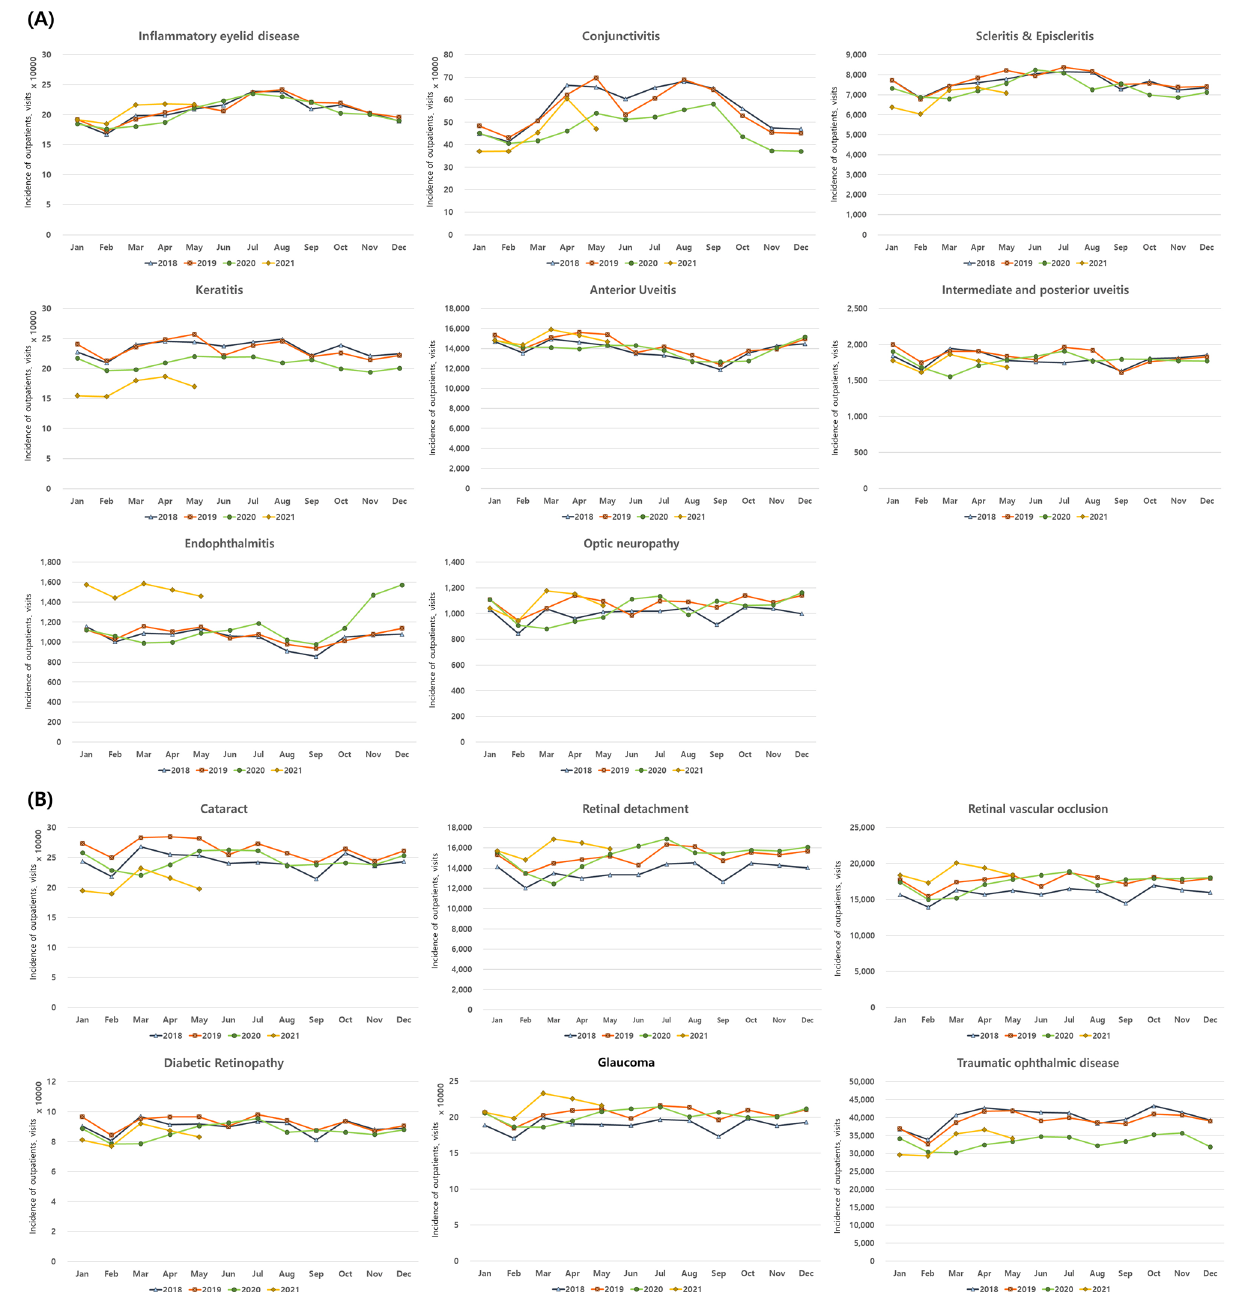
Figure 2. Monthly ophthalmic disease incidences (i.e., outpatient visits) during 2018, 2019, 2020, and 2021. The incidences of ( A ) infectious and inflammatory ophthalmic diseases (i.e., inflammatory eyelid disease, conjunctivitis, scleritis & episcleritis, keratitis, anterior uveitis, intermediate and posterior uveitis, endophthalmitis, and optic neuropathy) and ( B ) non-infectious and non-inflammatory ophthalmic diseases (i.e., cataract, retinal detachment, retinal vascular occlusion, diabetic retinopathy, glaucoma, and traumatic ophthalmic disease) are